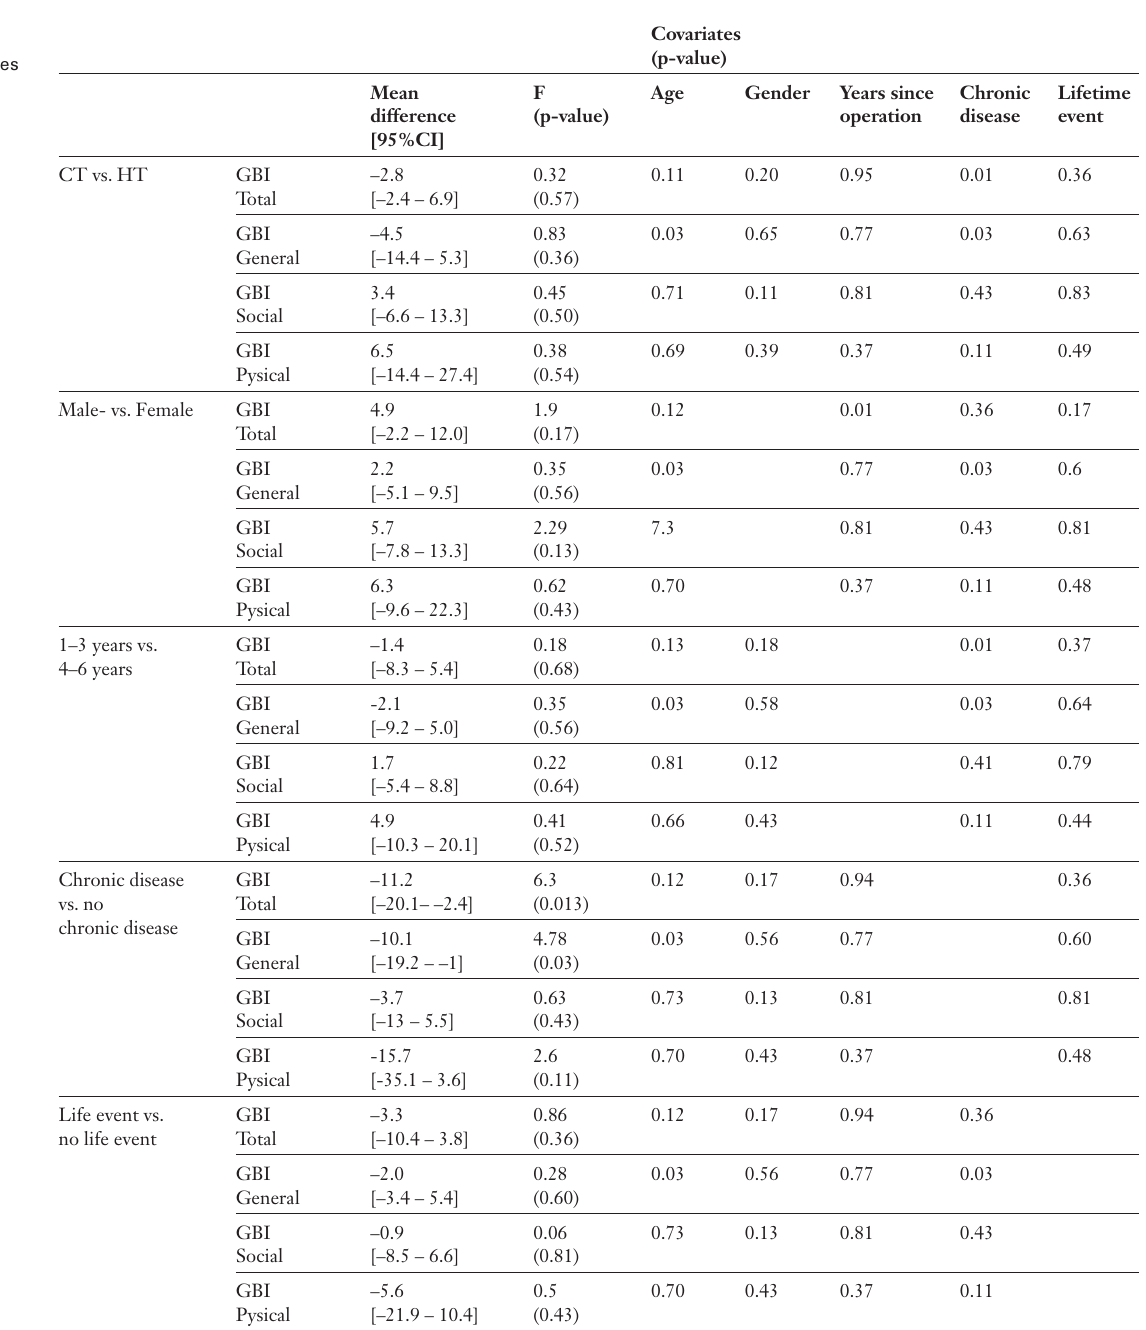
Multivariate analyses of